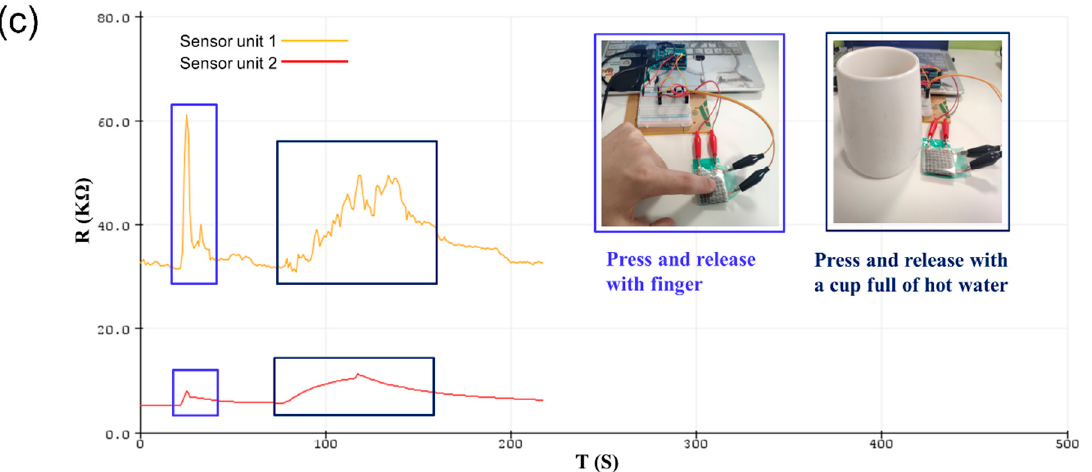
Figure 7. ( a ) Photograph of the signal processing circuit of the stretchable multimodal tactile sensor, ( b ) schematic of the signal processing circuit, and ( c ) real-time relative changes in resistance of the stretchable multimodal tactile sensor for monitoring finger pressing and pressing by a cup filled with hot water.